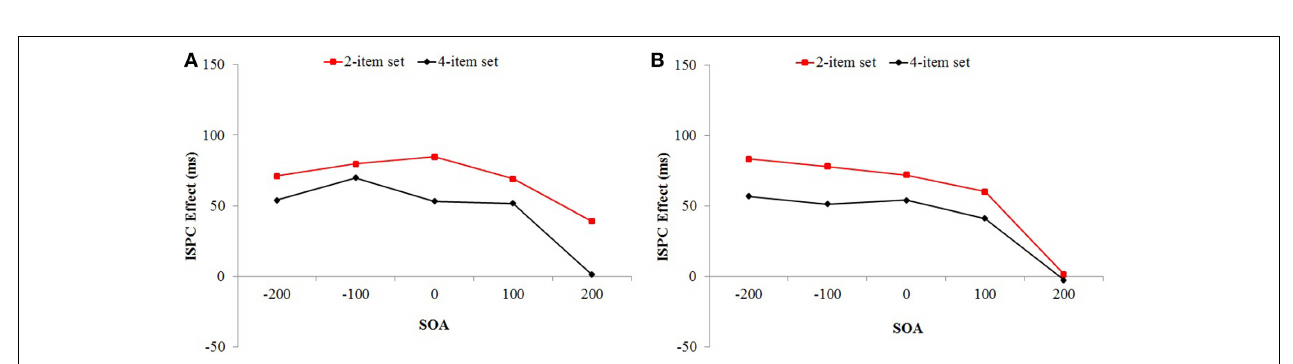
factors. There was a main effect of set size, F (1 , 104) = 6 .